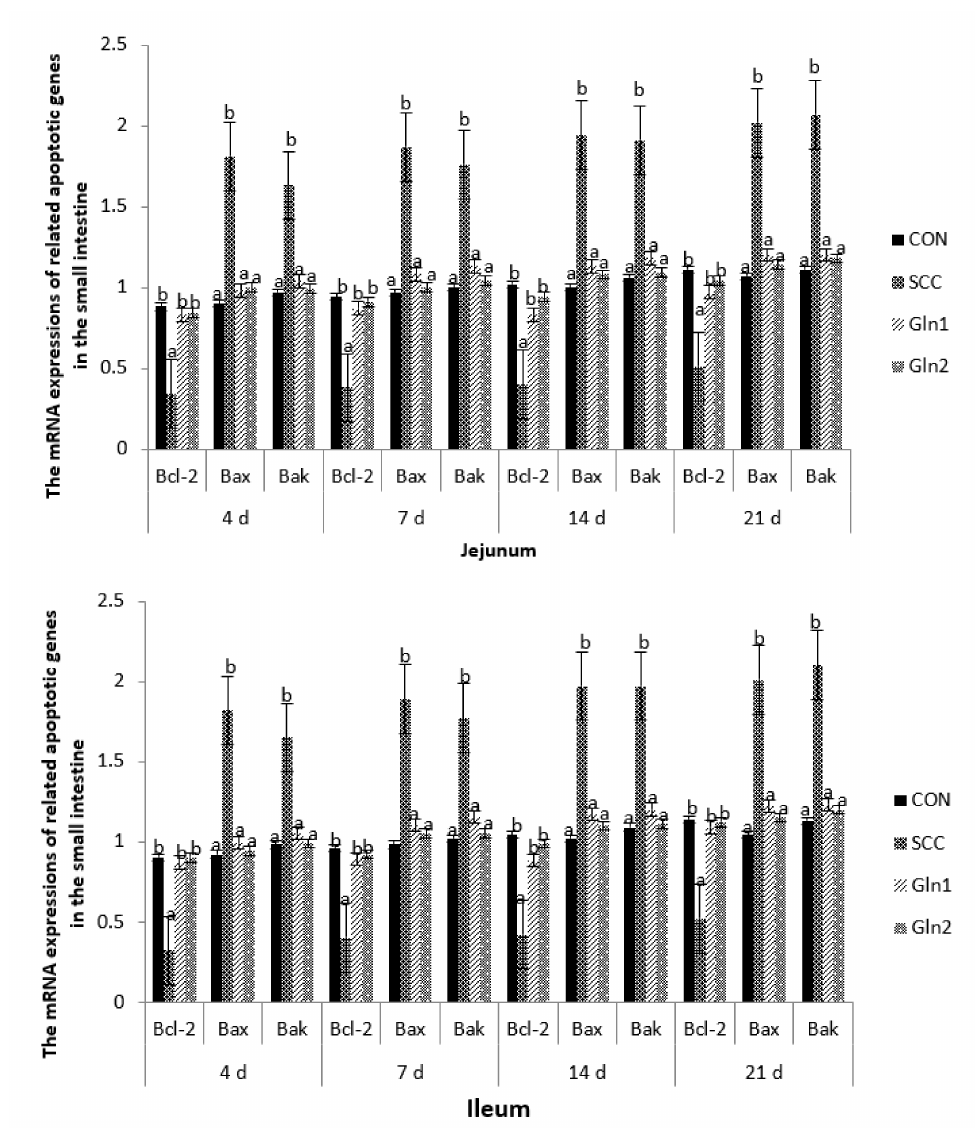
Figure 3. Effect of Gln on the related apoptotic genes mRNA expressions in the jejunum and ileum of broiler chickens that received S . Enteritidis. CON = a basal diet without added Gln and no challenged group, SCC = a basal diet without added Gln and received 2.0 × 10 4 CFU/mL of S. Enteritidis suspension group, Gln1 = a basal diet plus 0.5% Gln and fed 2.0 × 10 4 CFU/mL of S. Enteritidis suspension group, Gln2 = a basal diet plus 1.0% Gln and fed 2.0 × 10 4 CFU/mL of S. Enteritidis suspension group. a,b Means within a row with different superscripts are different at p < 0.05. n =